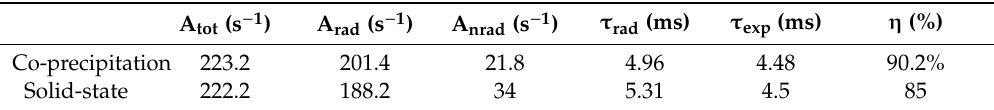
Table 2. Total, radiative and non-radiative transition rates, calculated and experimental decay time and quantum e ffi ciency of BMW: Eu 3 + .